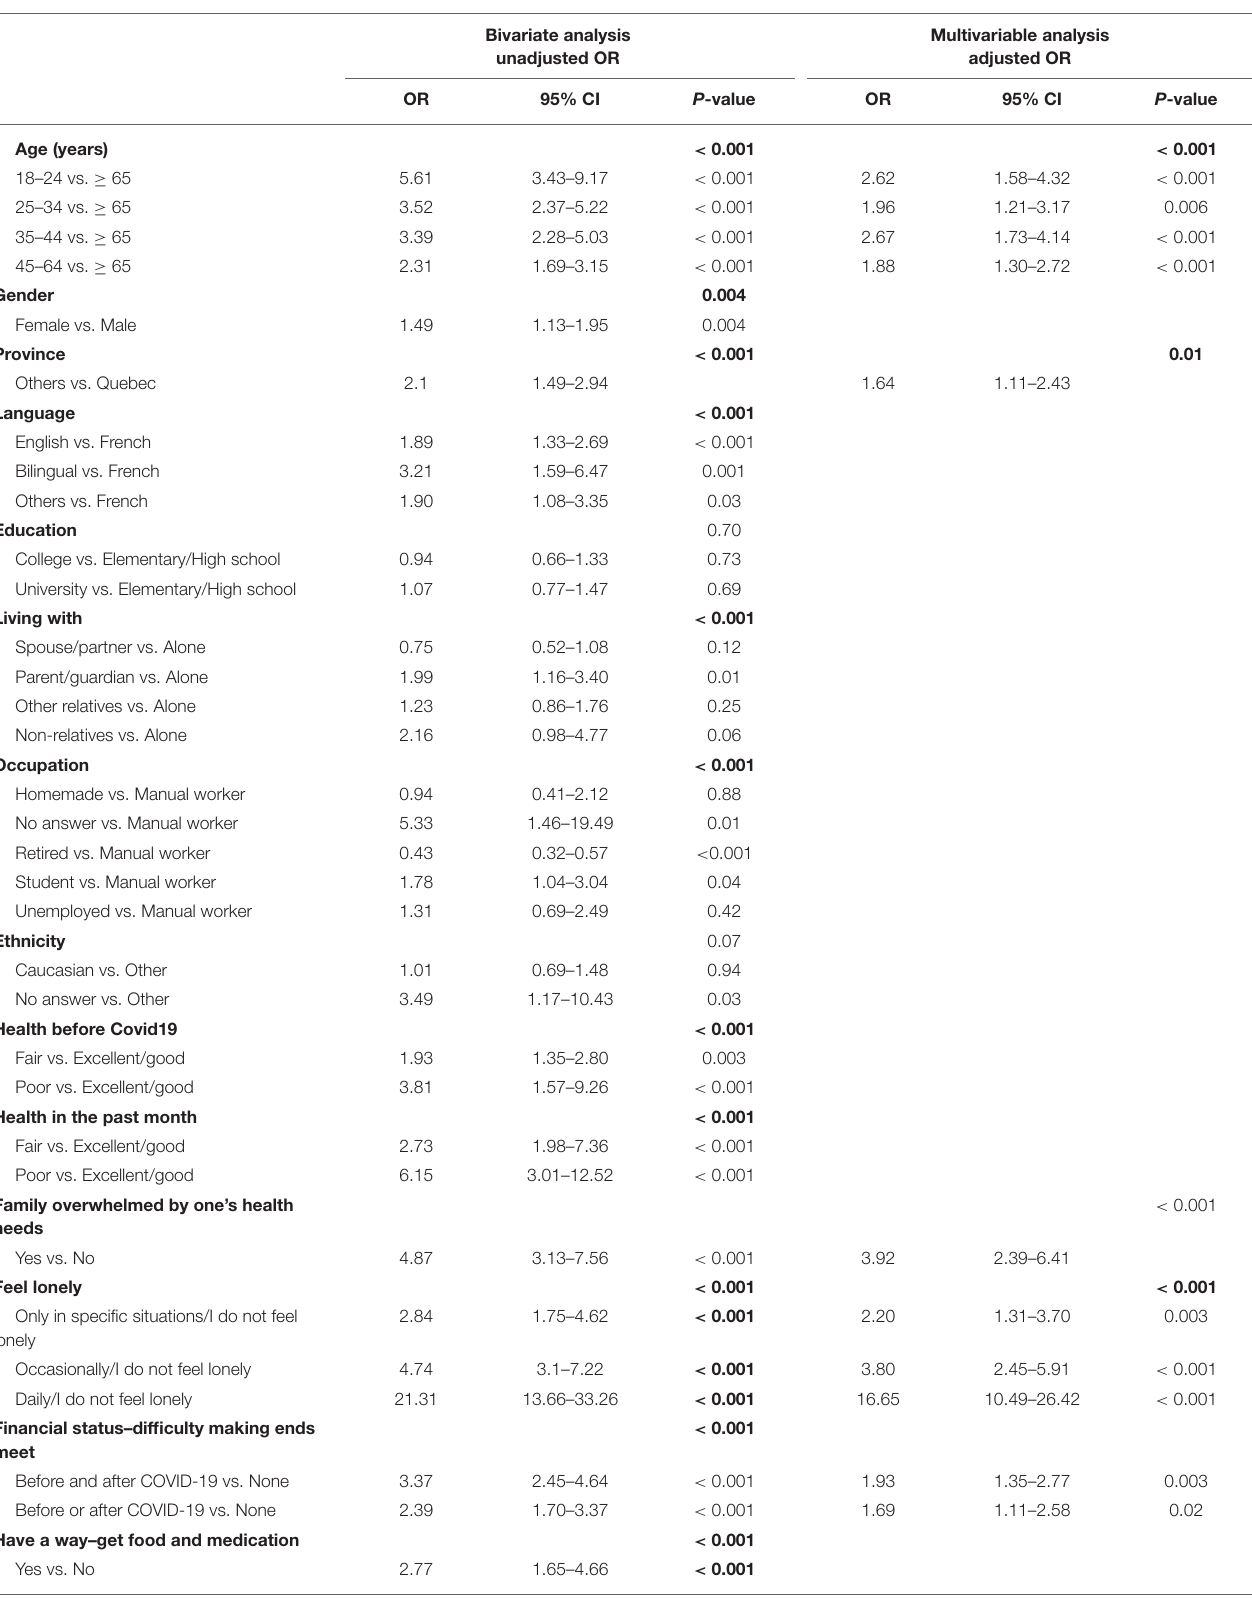
TABLE 2 | The association between score of 5 + on self-reported mood scale and a number of risk factors.